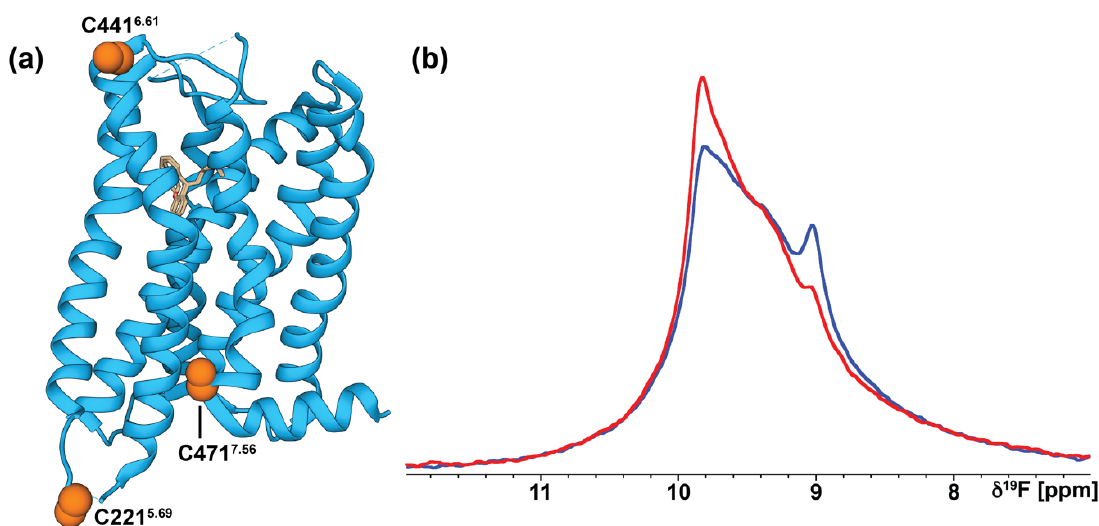
Figure 8. ( a ) The crystal structure of the H 1 R complex with doxepin is shown in ribbon representation (PDB ID 3RZE [9]). The 3 cysteines available for chemical modification are shown as orange spheres and labeled. ( b ) Superposition of 19 F-NMR spectra of human H 1 R in complex with the antagonist doxepin (blue) and agonist histamine (red) recorded at 7 °C.